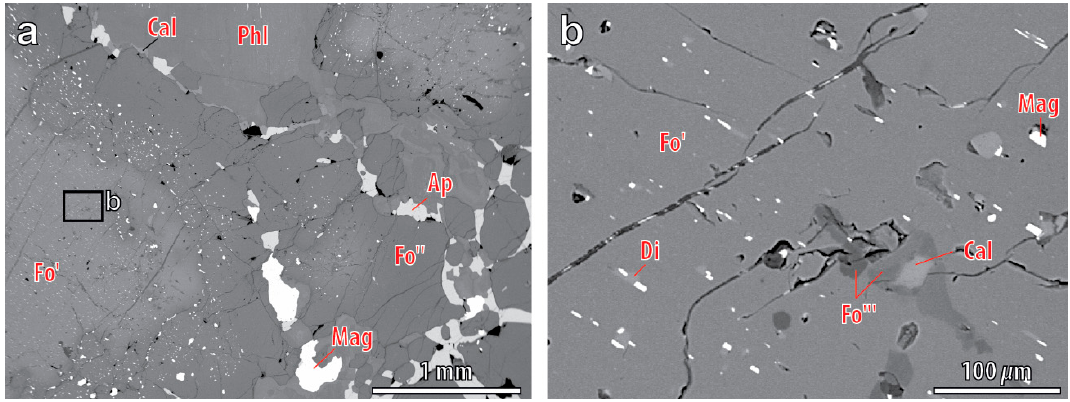
Figure 12. BSE-images of a rim of newly formed “phoscoritic” forsterite-II (Fo’’ = Fo 92 Fa 8 ) around relict grain of “peridotitic” forsterite-I (Fo’ = Fo 93 Fa 7 ) in А F-phoscorite 937/114.6 ( a ) and the enlarged region demonstrating diopside lamellae and calcite “drops” in forsterite ( b ). Fo’’’ = Fo 95 Fa 5 . Other mineral abbreviations see in the Section 3.